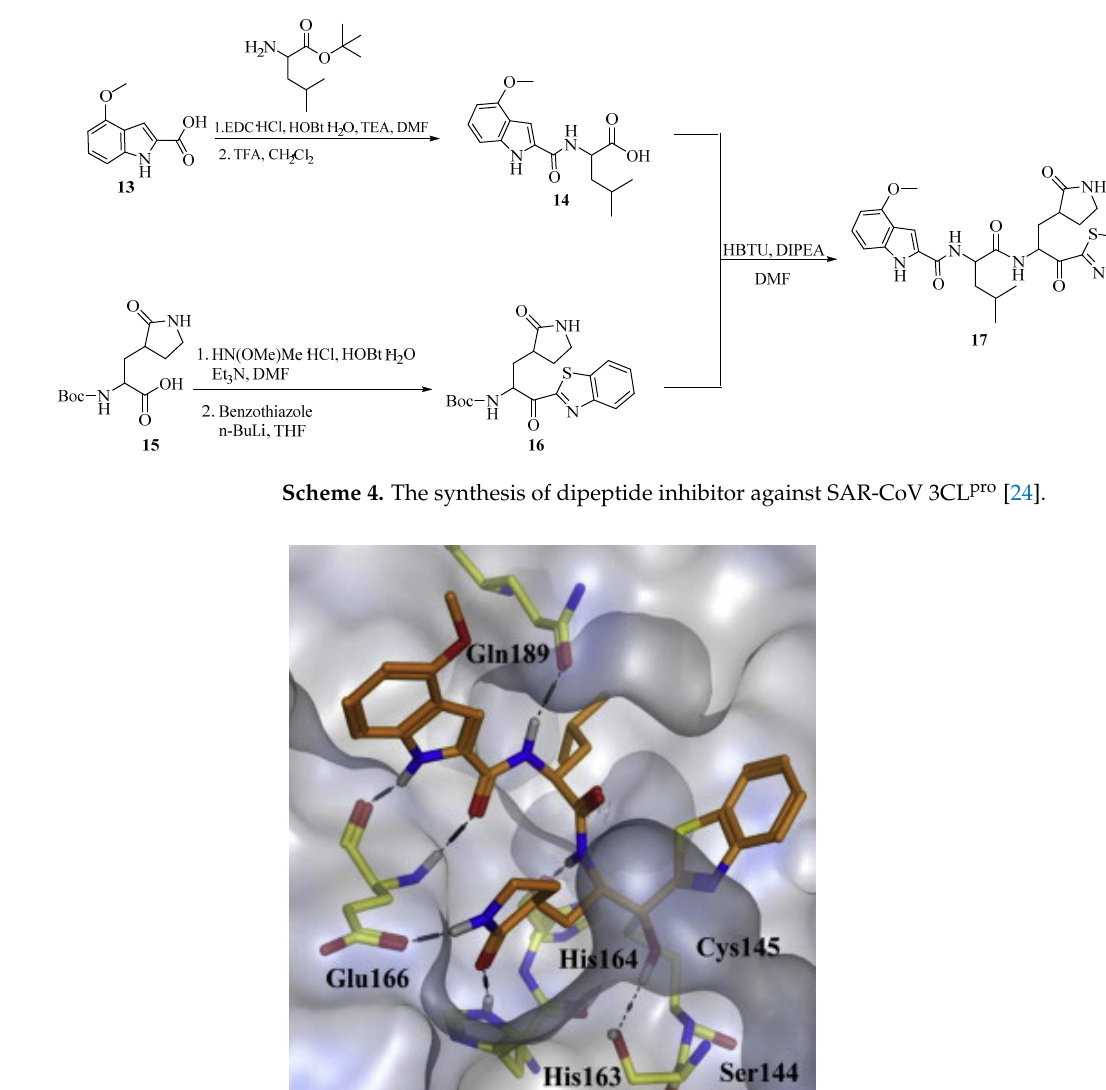
Figure 2. Molecular docking poses and binding interaction of 17 bound to SARS-CoV 3CL pro [24].